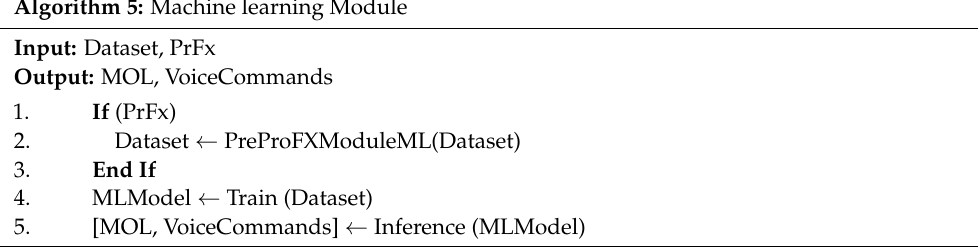
Algorithm 5: Machine learning